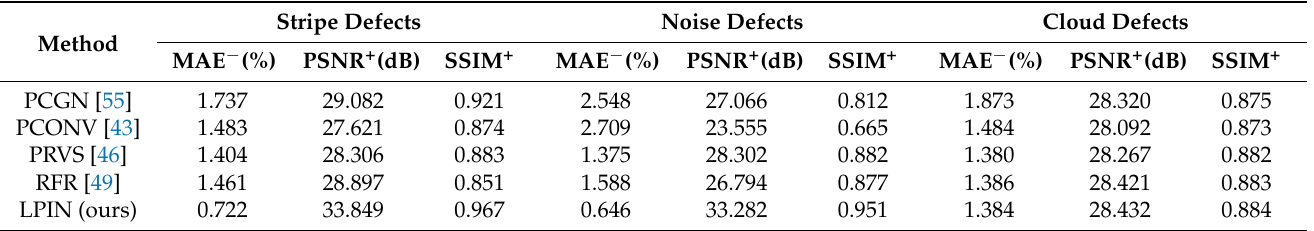
Table 3. Quantitative inpainting results of different methods.